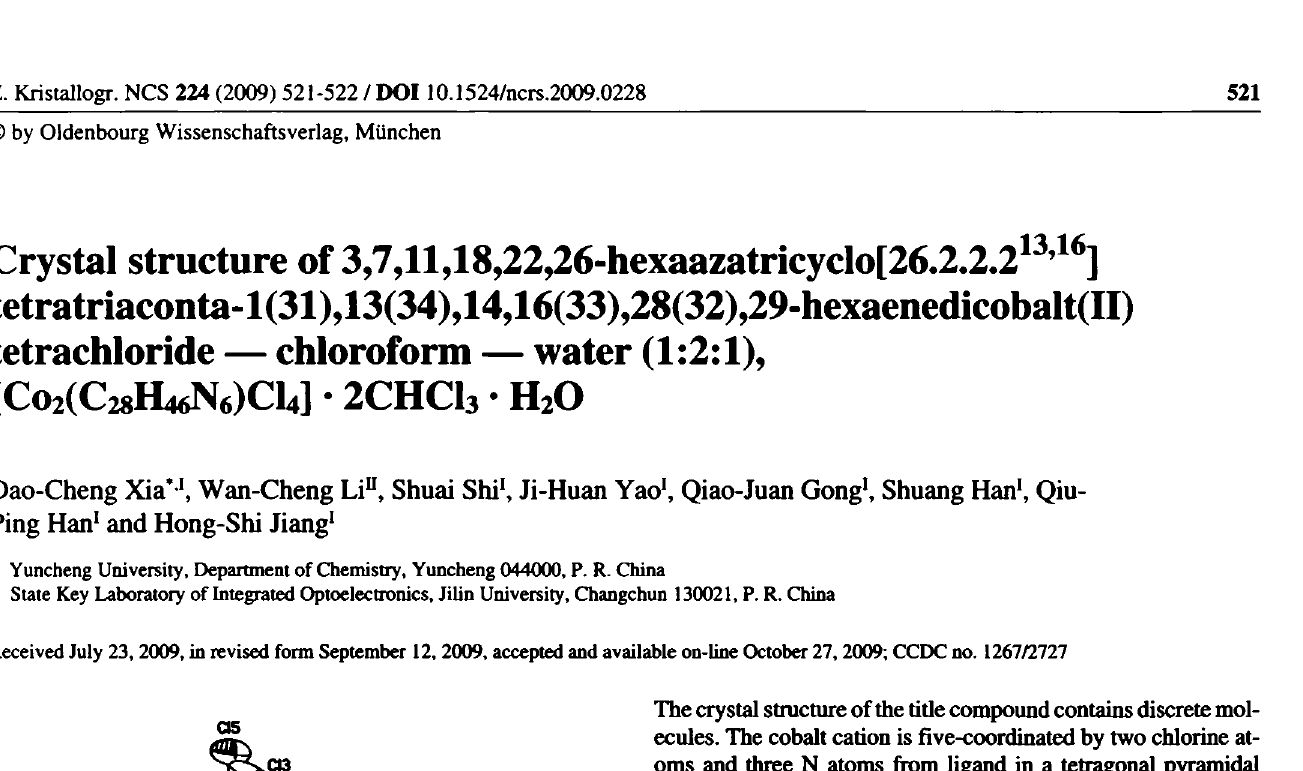
Table 1. Data collection and handling.